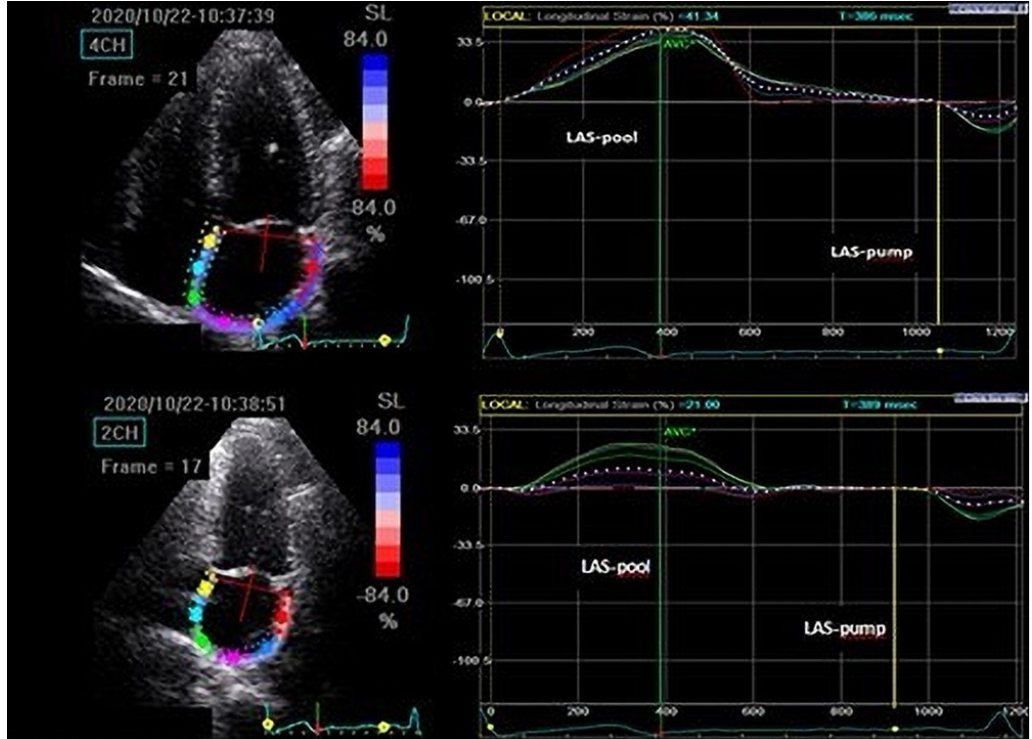
Figure 1. Left atrial two-dimensional speckle tracking echocardiography. Abbreviation: LAS, left atrium strain.